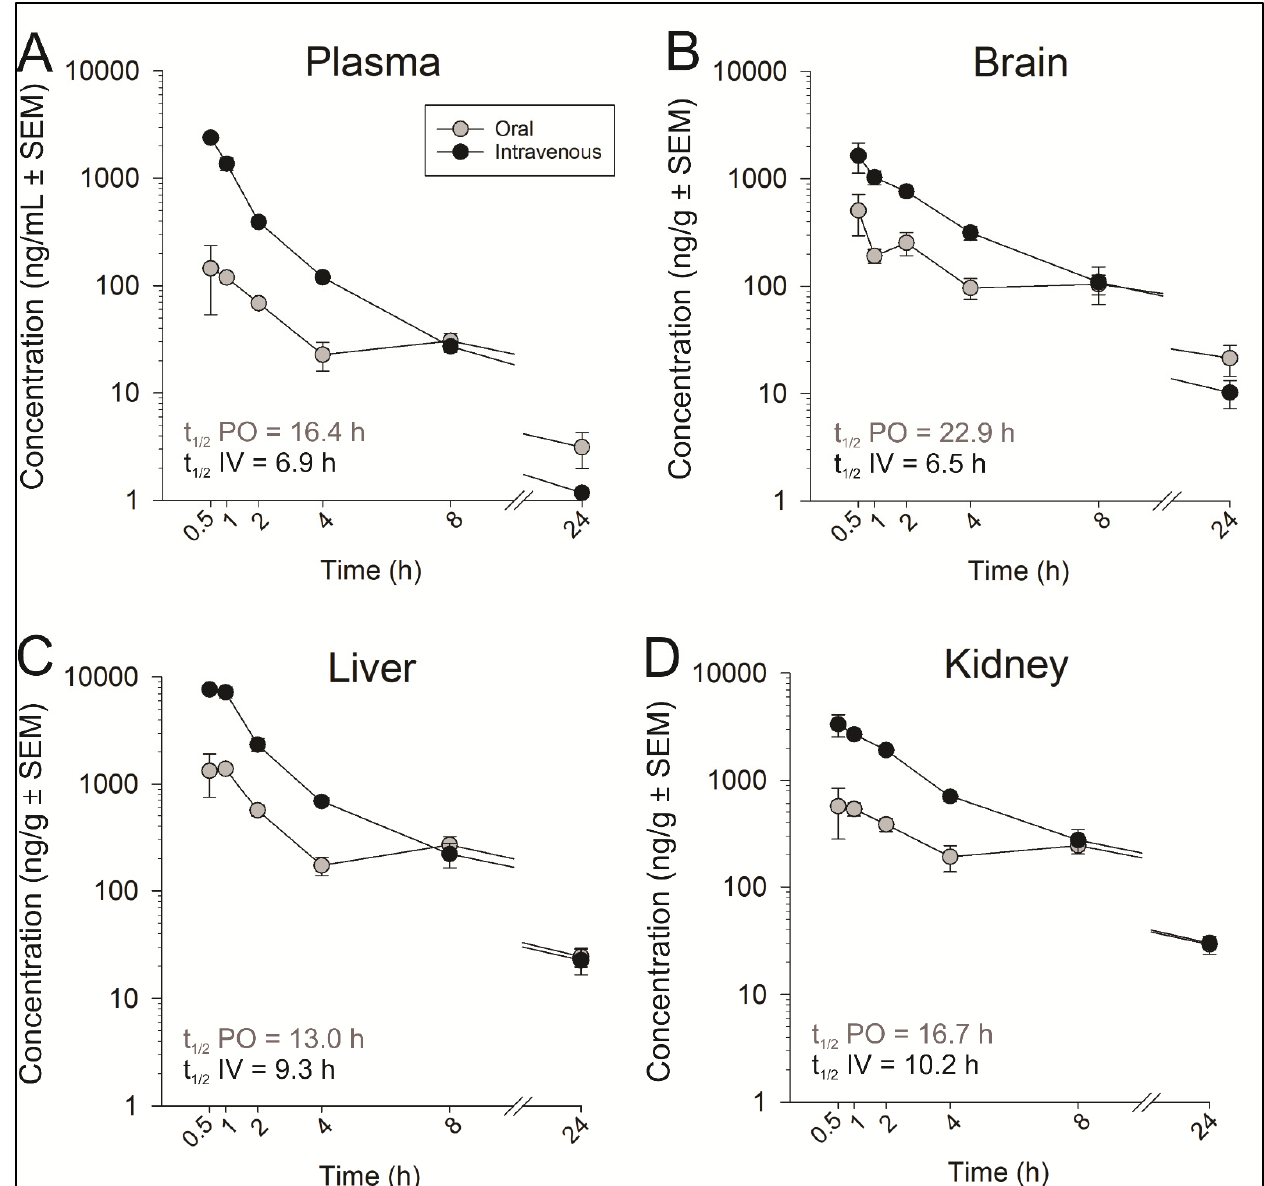
Figure 3. Pharmacokinetic profiles of compound 4k in plasma ( A ), brain ( B ), liver ( C ), and kidney ( D ) of CD1 mice following intravenous and oral dosing of 4k to mice at 5 mg/kg.